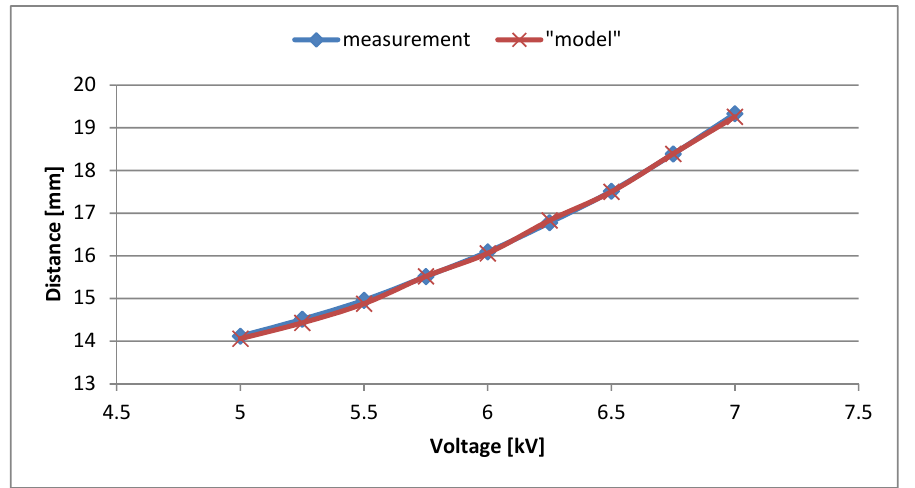
Figure 5. Comparison of membrane distances for static load force 1.03 [N]. Table 4. The comparison of the displacements for different voltage supply and load force 1.23[N]. Voltage Table 5. The comparison of the displacements for different voltage supply and load force 1.42[N]. Voltage